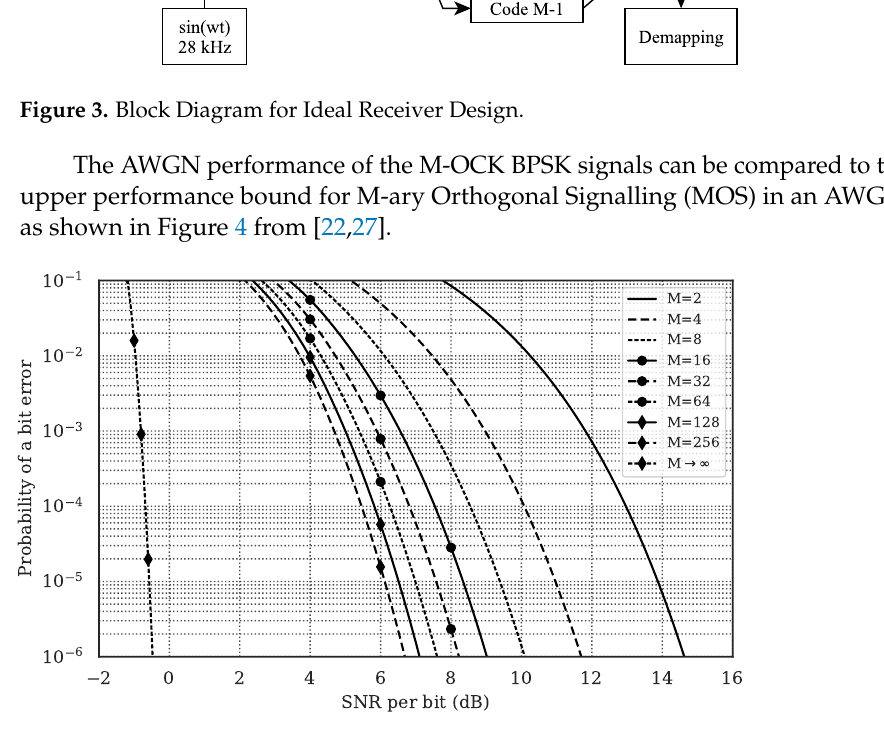
Figure 4. Upper Bound BER vs. (cid:101) b / N 0 for M-ary Orthogonal Signaling (MOS) generated using the formula by Proakis [27], as shown by Sherlock et al. [22]. With various values of M ranging from 2 to 256. For M → ∞ the value used is M = 2 1000